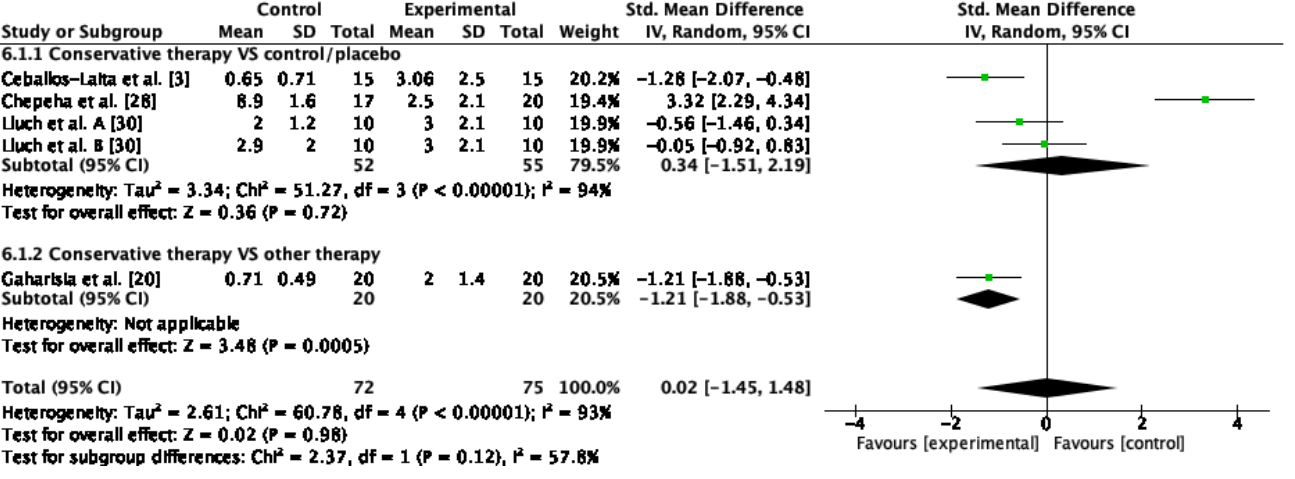
Figure 8. Forest plot of pain intensity for conservative therapy versus control/sham and conserva- tive therapy versus other conservative therapy. Lluch et al. A. compared manual therapy versus control intervention. Lluch et al. B compared the manual contact versus control intervention.